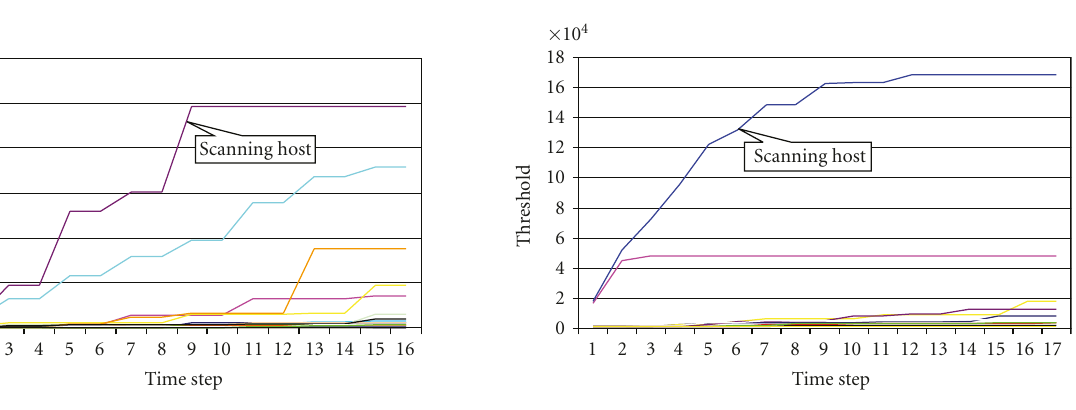
Figure 8: USC tra ffi c threshold analysis (FIN scan). Figure 9: USC tra ffi c threshold analysis (RST